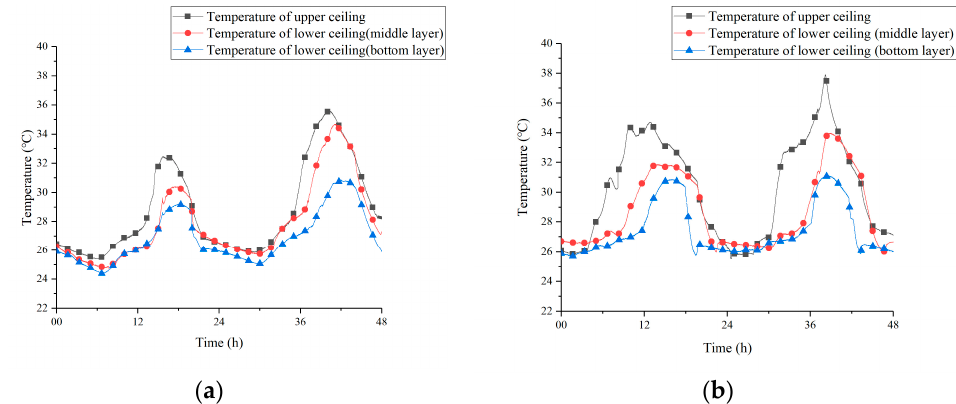
Figure 12. Vertical contrast of ceiling temperature under the two strategies ( a ) 12 h; ( b ) 8 h.